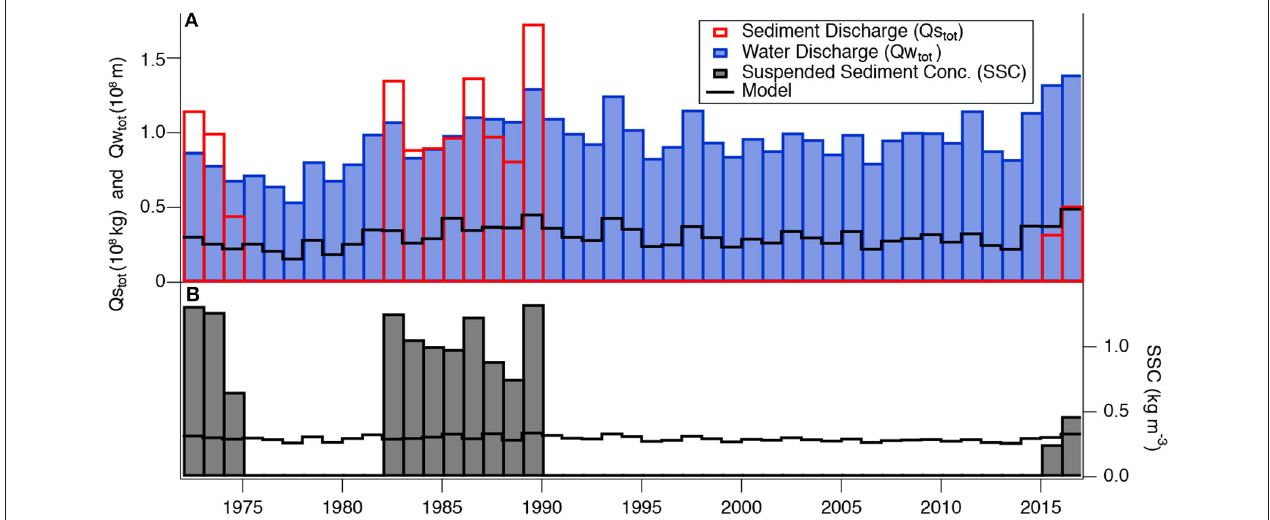
FIGURE 5 | Historical sediment and water discharge totals (A) and mean seasonal suspended sediment concentration (B) from the Gornergletscher catchment. Data aside from the 2016 and 2017 are from previous publications ( Table 1 ). Breaks in the plot indicate periods without measurements. Black lines are empirical model outputs described in Section